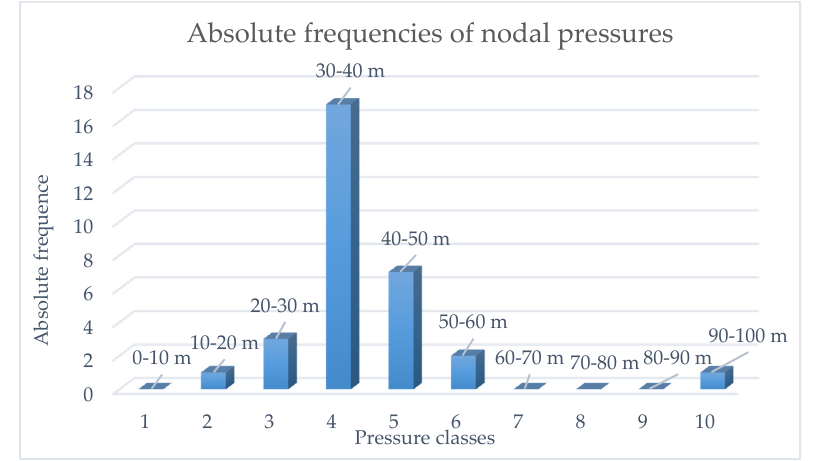
Figure 9. Histogram of absolute frequencies of nodal pressures of HAN solution 3.